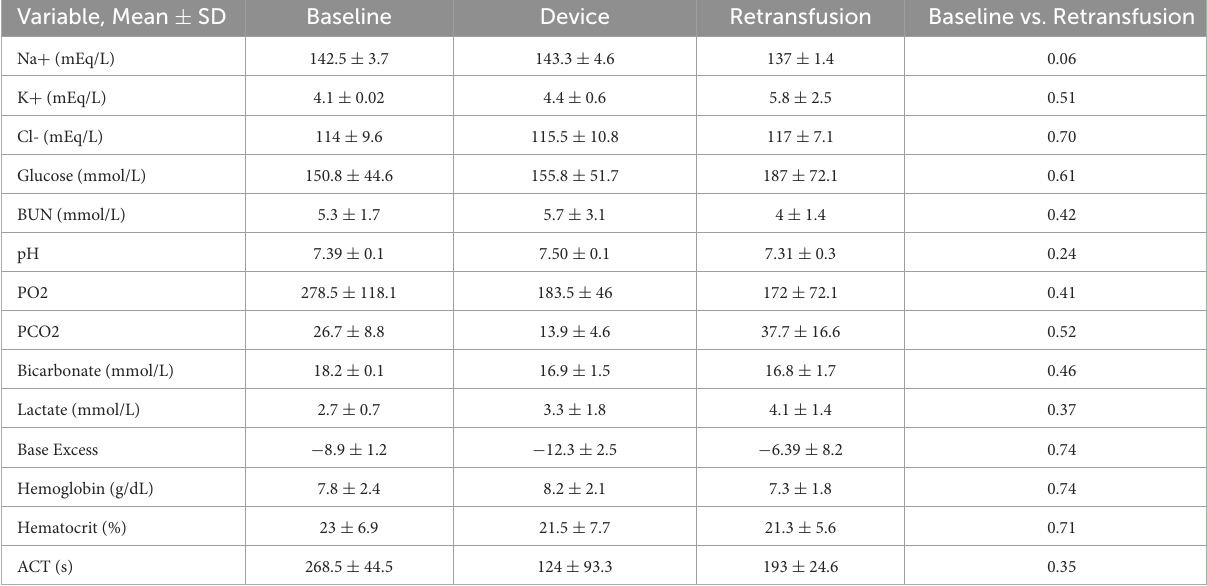
TABLE 1 Metabolic, arterial blood gas, and hematologic laboratory data. Variable, Mean ±